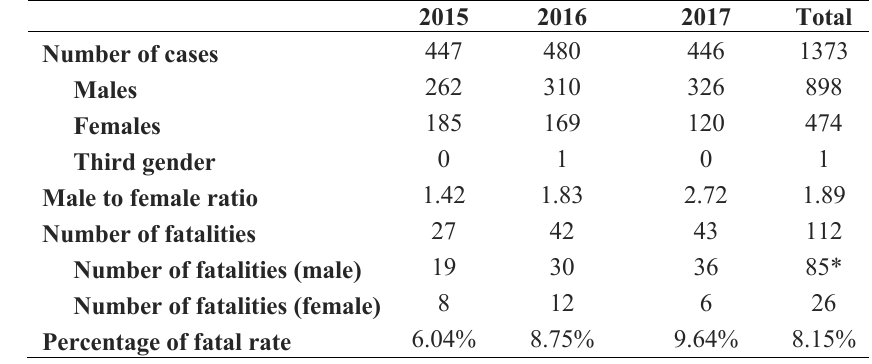
Table 1. Data on poisoning cases reported to poison information